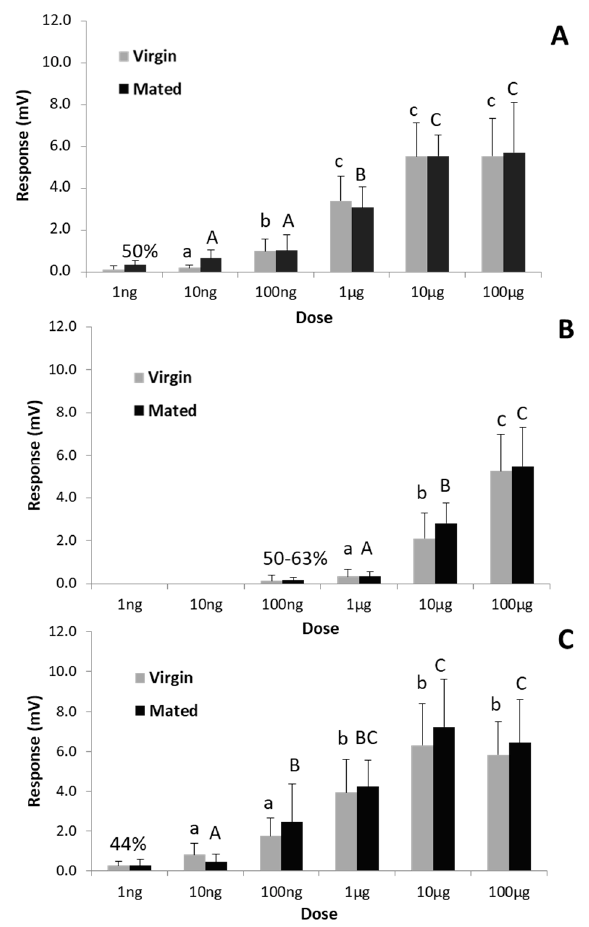
Figure 3. Mean EAG response (+ SE) of antennae of virgin and mated Tuta absoluta males (N = 9) to different doses of the pheromone components TDTA ( A ) and TDDA ( B ) and their mixture in 9:1 ratio ( C ). Bars with different letters within the same mating status (in lower case virgin and in capital mated males) are significantly different (Tukey post hoc test, p < 0.05). Percentage on bars indicates the number of insects responding to the corresponding dose but the EAG values were not taken into consideration for statistical analysis.